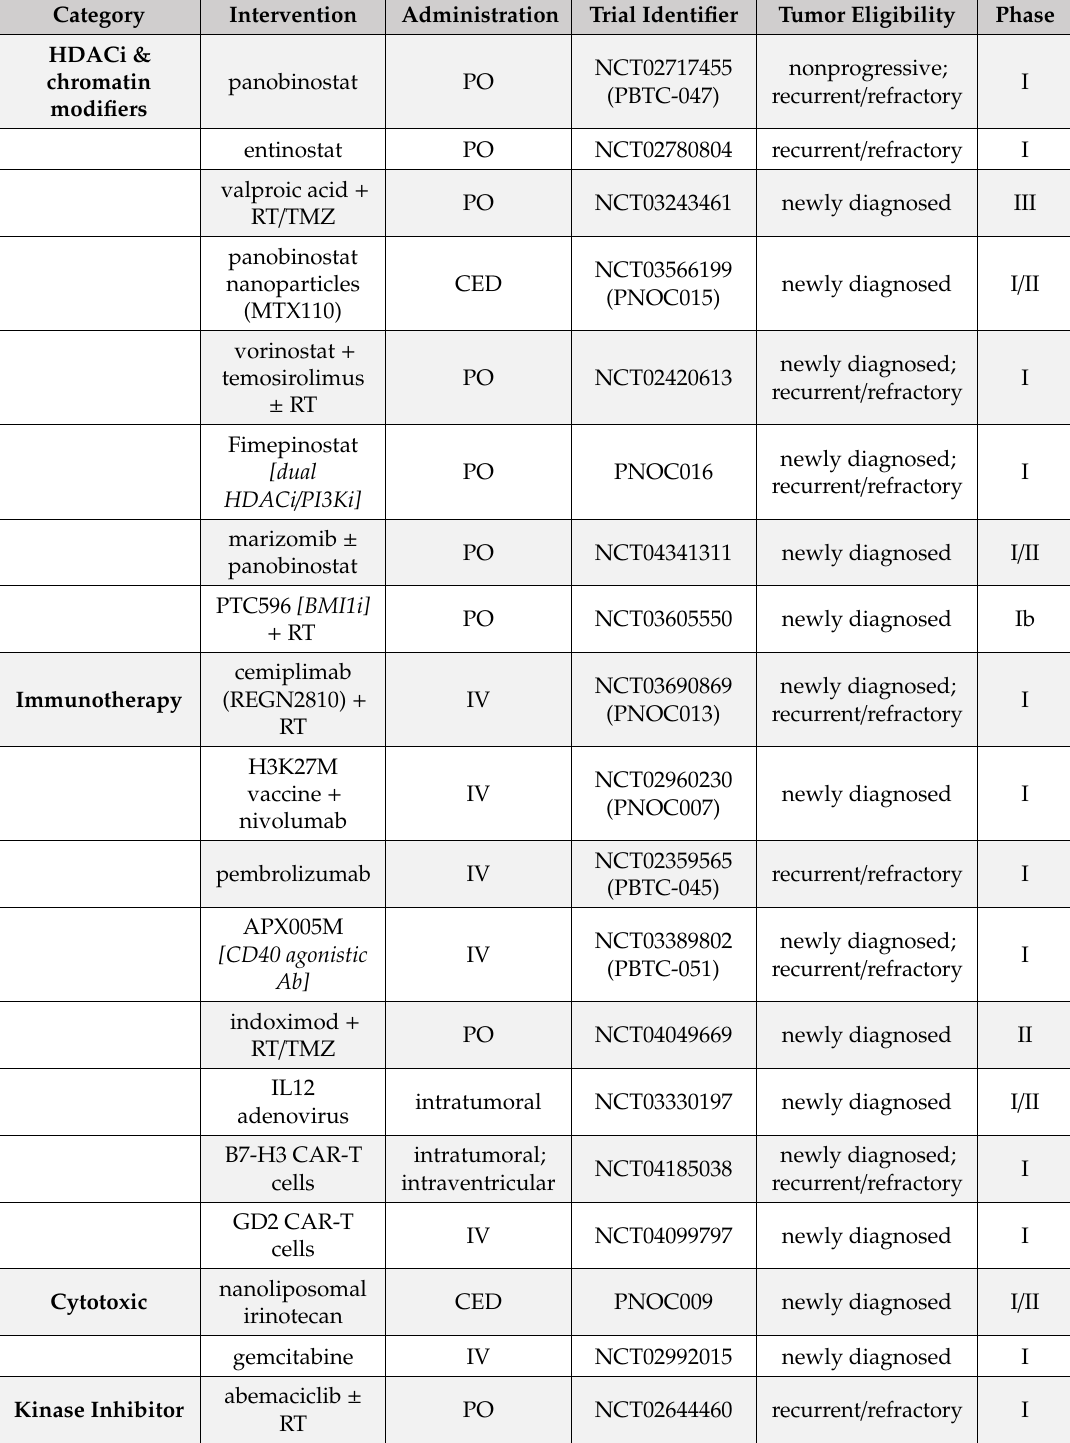
Table 2. Ongoing clinical trials for histone-mutant pHGG. BMI1: B cell-specific Moloney murine leukemia virus integration site 1; CED: convection enhanced delivery; IDO: indoleamine 2,3-dioxygenase; IL12: interleukin 12; IV: intravenous; PO: oral; RT: radiotherapy; TMZ: temozolomide. See text for other abbreviations common to multiple tables and